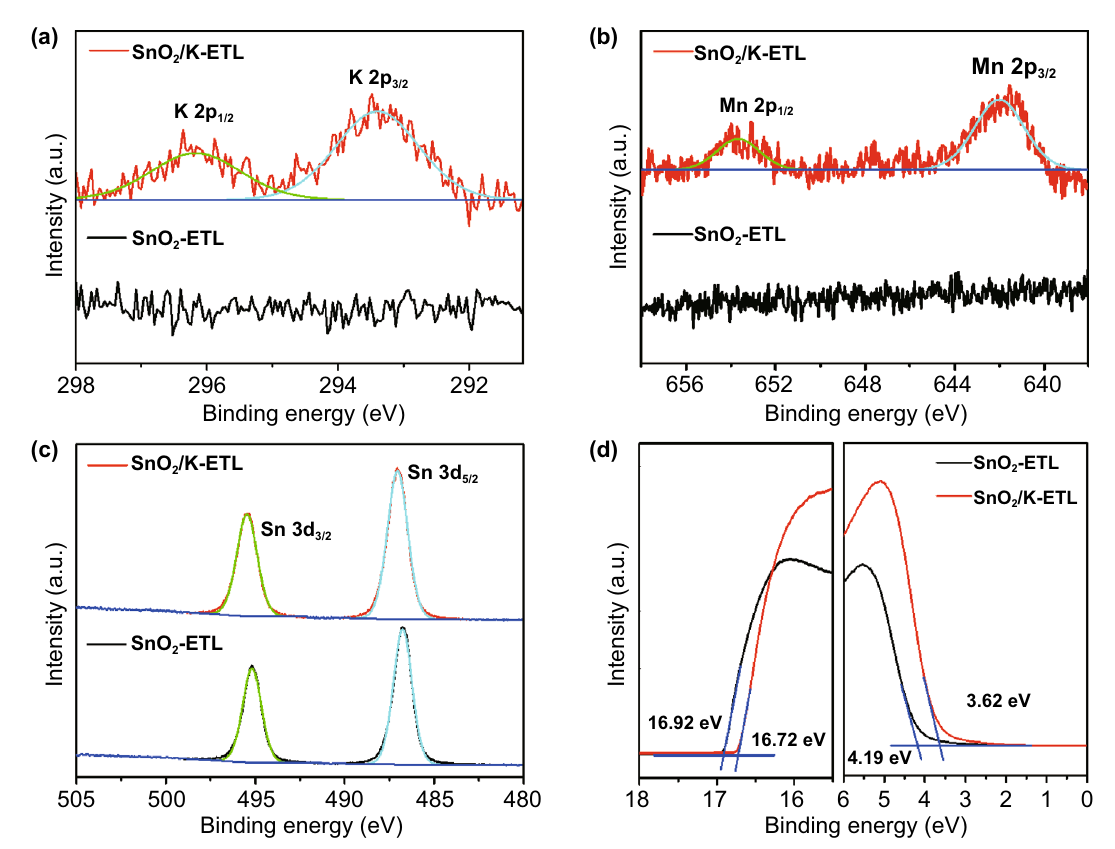
Fig. 2 Characterization of SnO 2 and SnO 2 /K Films. XPS spectra of the SnO 2 -ETL and SnO 2 /K-ETL films. a K 2p, b Mn 2p ( B ) and c Sn 3d. d UPS spectra acquired on the